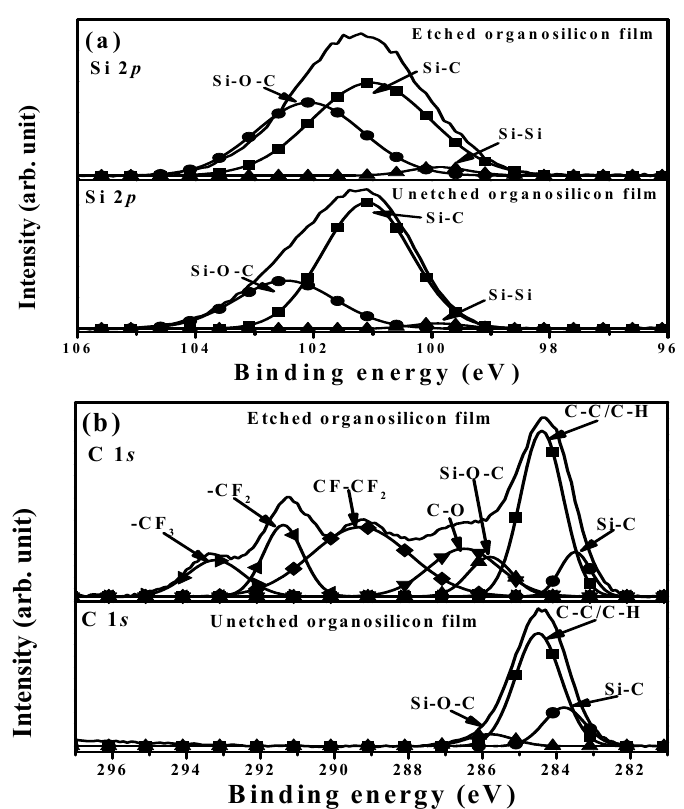
Figure 12. XPS spectra of the ( a ) Si 2 p and ( b ) C 1 s core levels for the organosilicon films with and without the CF 4 plasma etching.